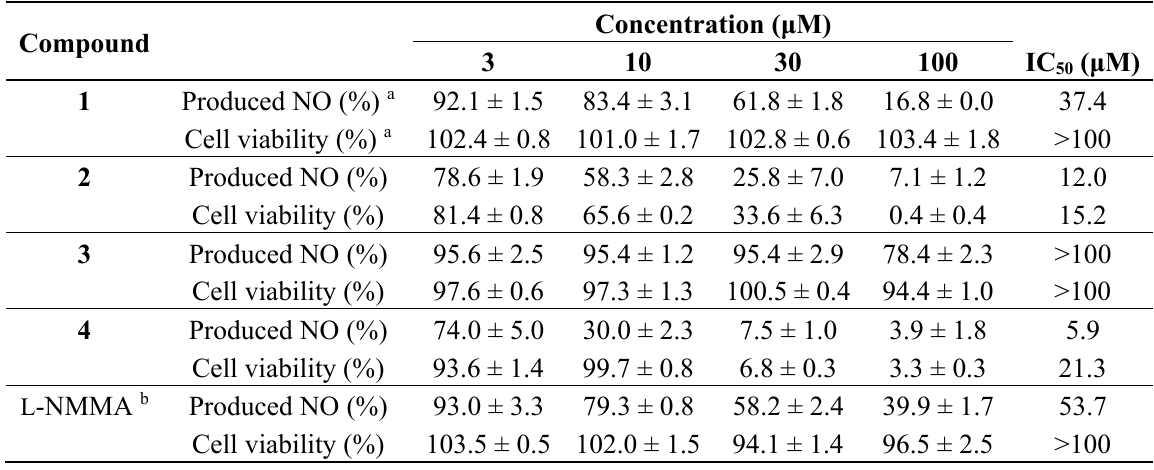
Table 3. Inhobitory effects of NO production by limonoids from the seeds of Carapa guianensis .